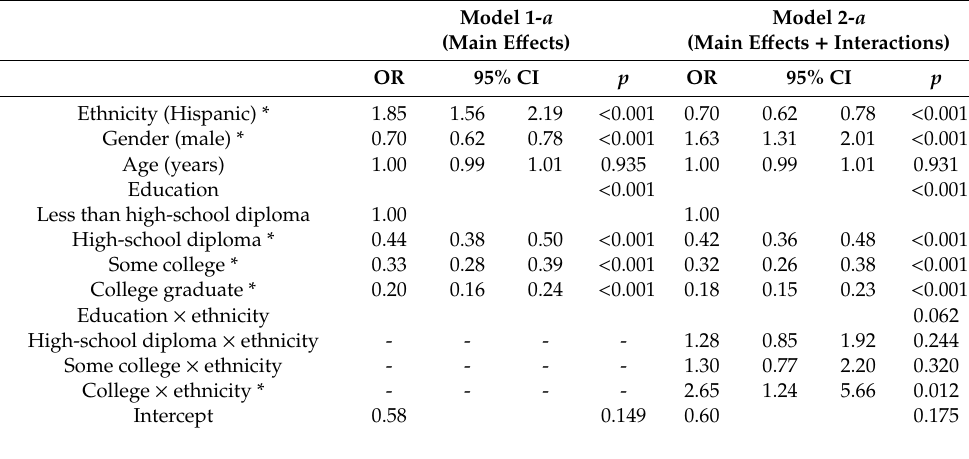
Table 2. Pooled sample and ethnic-specific logistic regressions of depressive symptoms over 24 years. OR—odds ratio; CI—confidence interval.